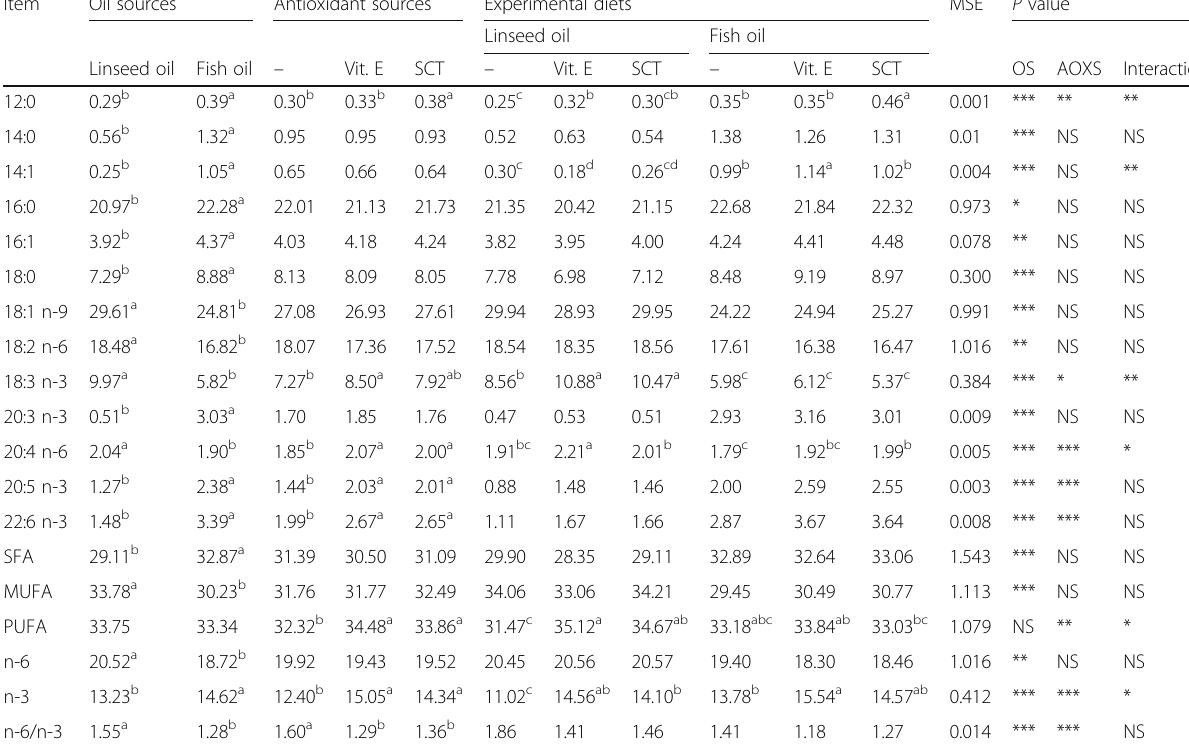
Table 3 Fatty acids composition (g/100 g fatty acids) of meat of broilers fed diets containing different sources of oils and